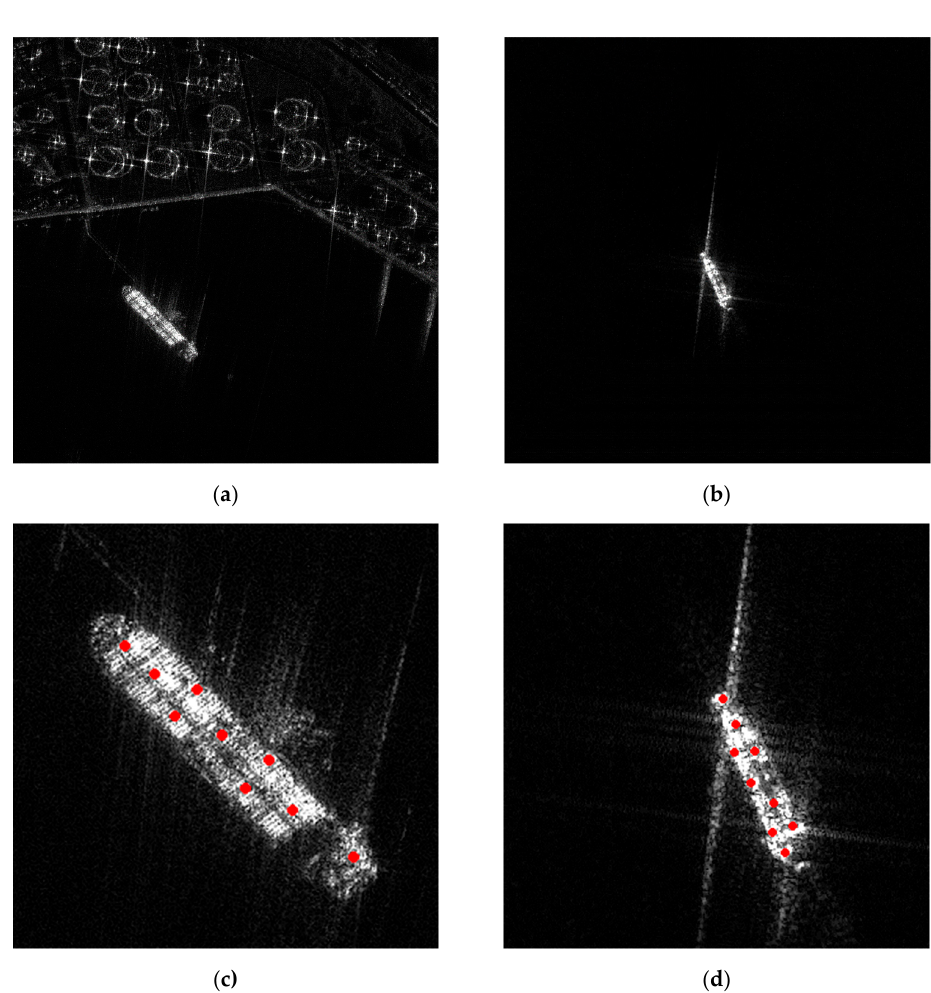
Figure 4. Extracted key scattering points in a SAR image. ( a , b ) Origin SAR images of containers. ( c , d ) key scattering points.